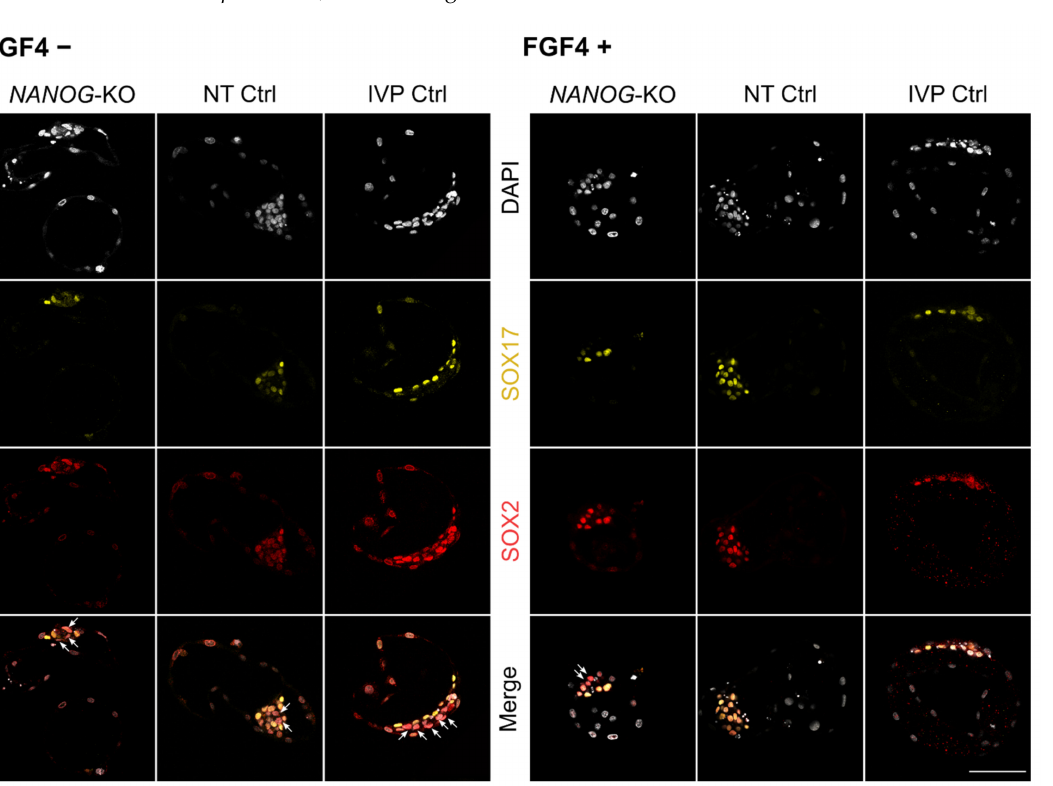
Figure 3. Developmental rates and cell number ratios of NANOG, SOX17, and exclusive SOX2 in NANOG -KO, NT Ctrl, and IVP Ctrl day 8 embryos treated with exogenous FGF4 and heparin. ( A ) Blastocyst per morula rate, ( B ) total cell number, ( C ) proportion of ICM to total cell number, ( D ) ratio of NANOG-positive cells in the ICM, ( E ) ratio of SOX17-positive cells in the ICM, and ( F ) ratio of cells exclusively expressing SOX2 in the ICM of NANOG -KO (black), NT Ctrl (red), and IVP Ctrl (blue) embryos without ( − ) and with (+) FGF4 and heparin are presented. ICM cells were determined by staining of SOX2. Data were analyzed by two-tailed Mann–Whitney U test and are presented as mean (%) ± standard deviation. Asterisks indicate significant effects of FGF4 treatment within embryo group. N = number of analyzed embryos, * p < 0.05; ** p < 0.01; *** p < 0.001; **** p < 0.0001; n.s. = not significant.